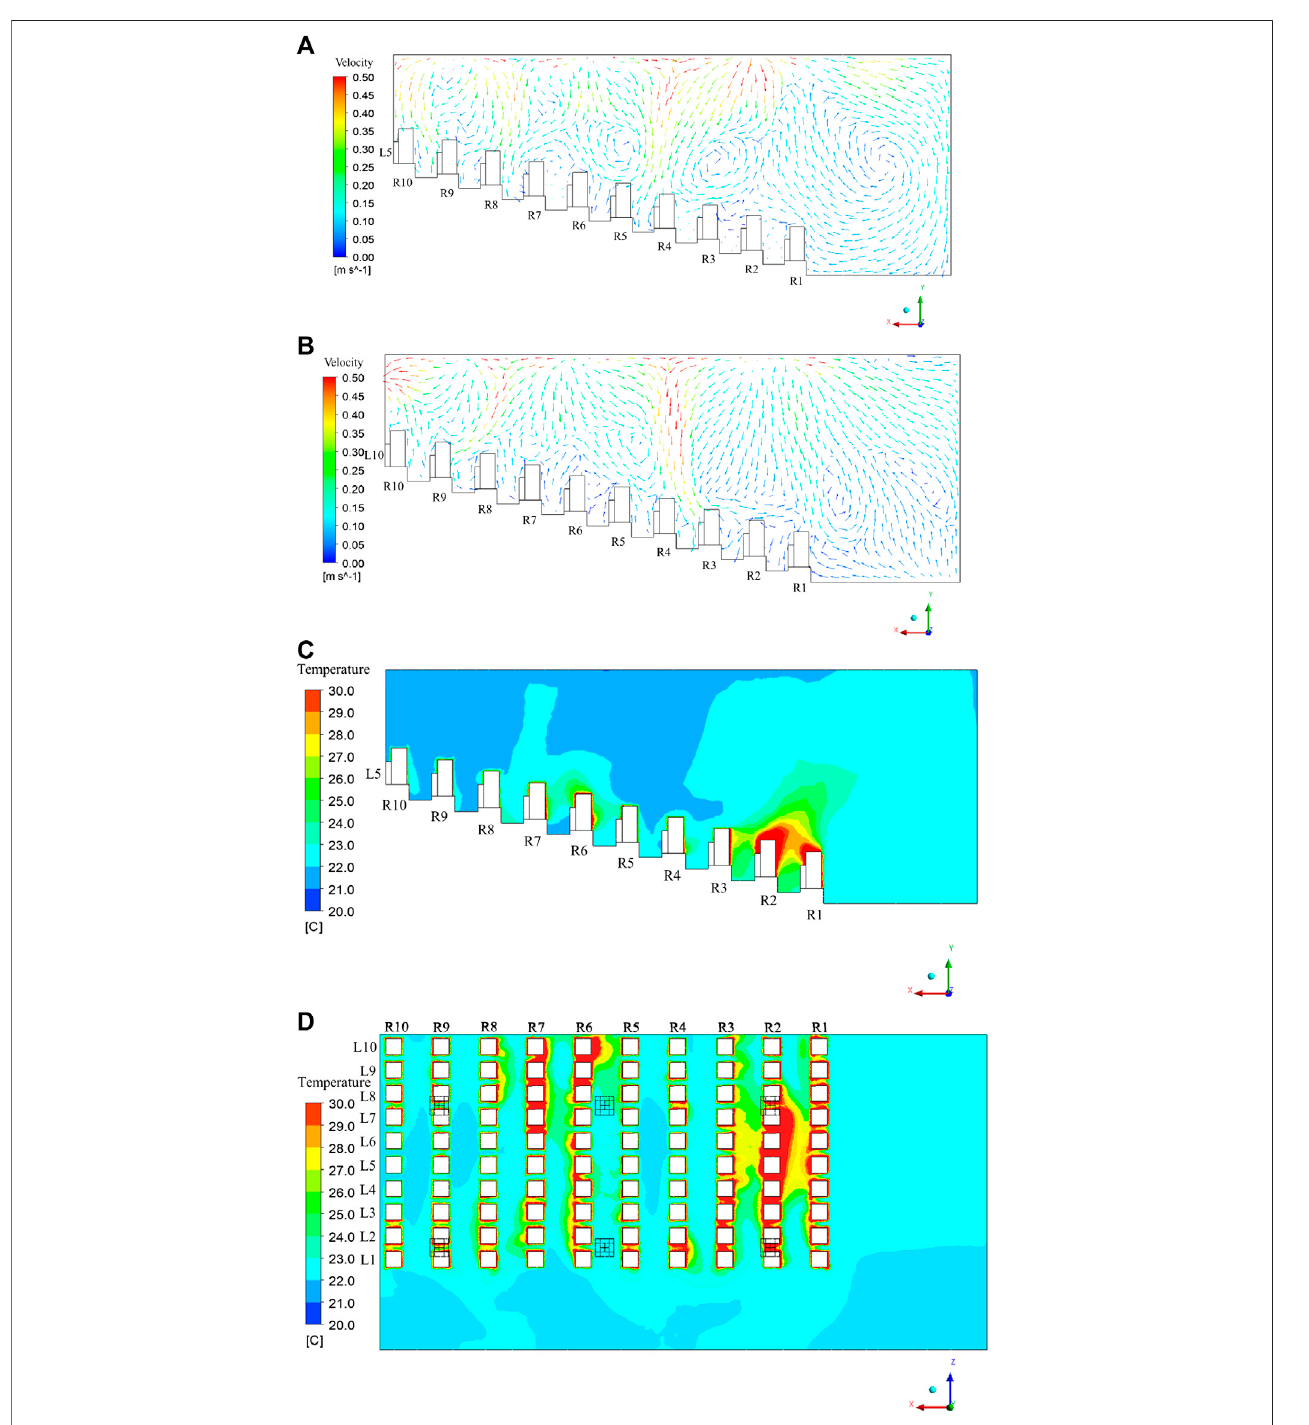
FIGURE 5 | Flow fi eld and temperature distribution in the theater hall: (A) fl ow fi eld in Plane 1; (B) fl ow fi eld in Plane 2; (C) temperature distribution in Plane 1; (D) temperature distribution in Plane 3.